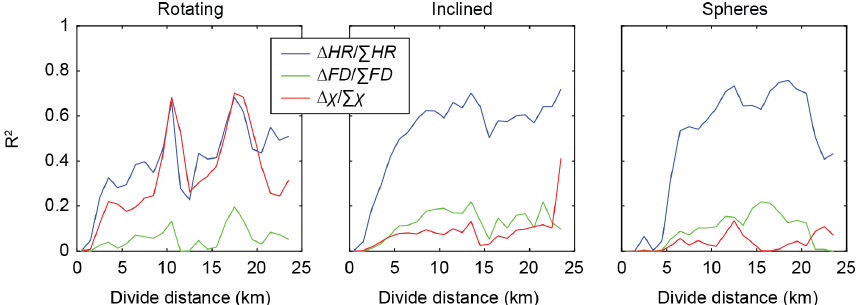
Figure 12. Coefficient of determination for linear regressions between normalized across-divide differences in different topographic metrics (HR: hillslope relief; FD: flow distance; χ : chi) and normalized across-divide differences in erosion rates as a function of drainage divide distance in the three perturbation